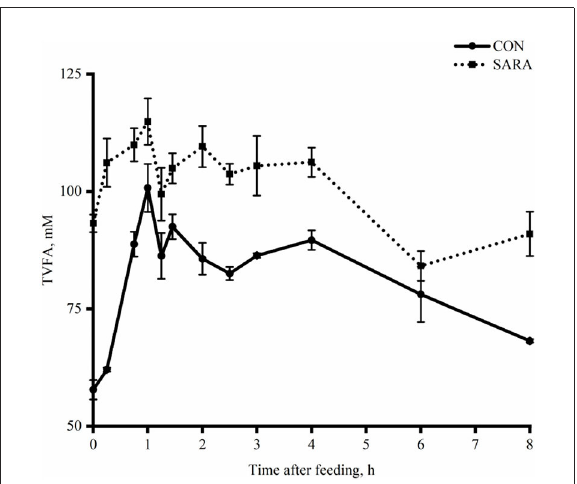
FIGURE2 The dynamic variation of total volatile fatty acids in the rumen fluid of goats under normal (CON) or SARA condition. Data were